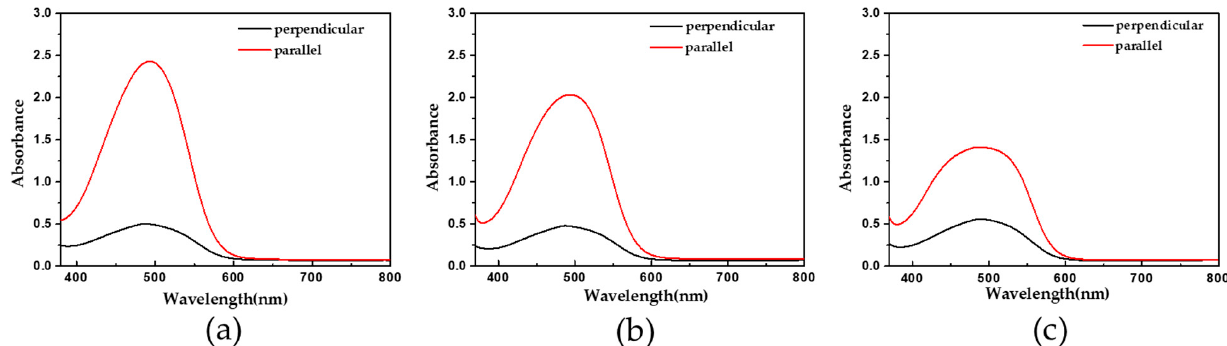
Figure 2. The absorption of dichroic dye (RL-002) in nematic cells with different alignment layers: ( a ) PVA–PVA; ( b ) PVA– PVK; ( c ) PVK–PVK. Table 2. S measured for 5CB cells with different alignment layers.